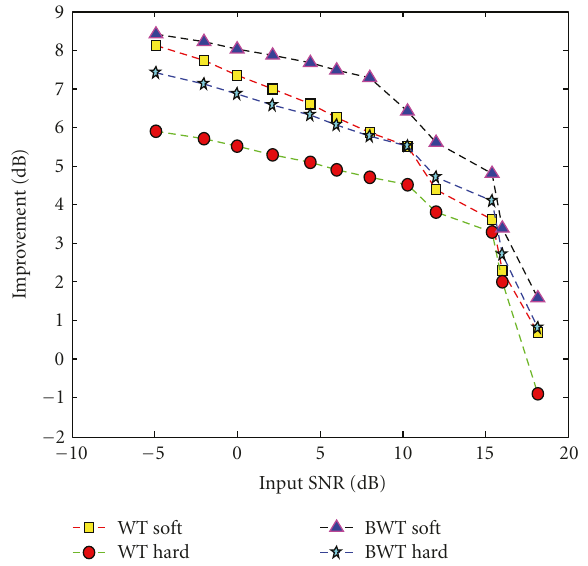
Figure 8: WT and MABWT filter output SNR improvement ver- sus di ff erent input SNRs for the first 4096 samples of the MIT-BIH record number 100.